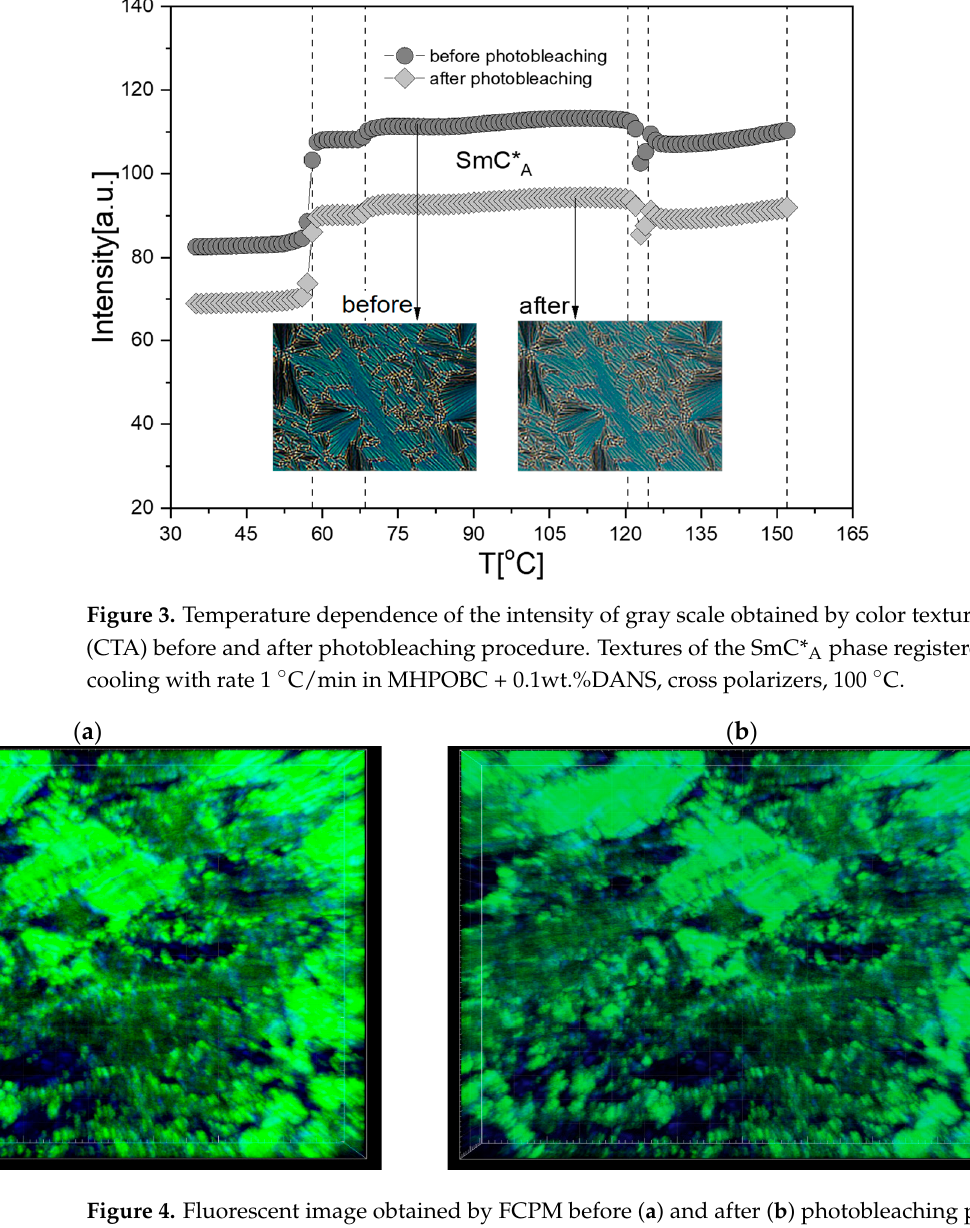
Figure 4. Fluorescent image obtained by FCPM before ( a ) and after ( b ) photobleaching procedure. Pictures show MHPOBC + 0.1wt.%DANS in the antiferroelectric SmC* A phase, 100 °C.